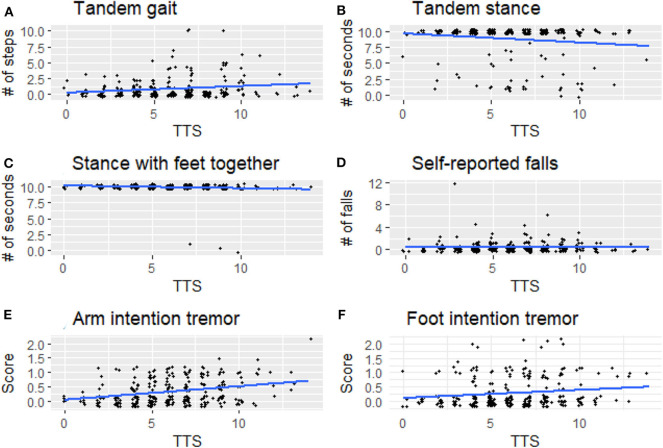
Signs of cerebellar dysfunction [(A) tandem gait, (B) tandem stance, (C) stance with feet together, (D) self-reported falls, (E) arm intention tremor, (F) foot intention tremor] plotted against TTS. TTS, total tremor score.